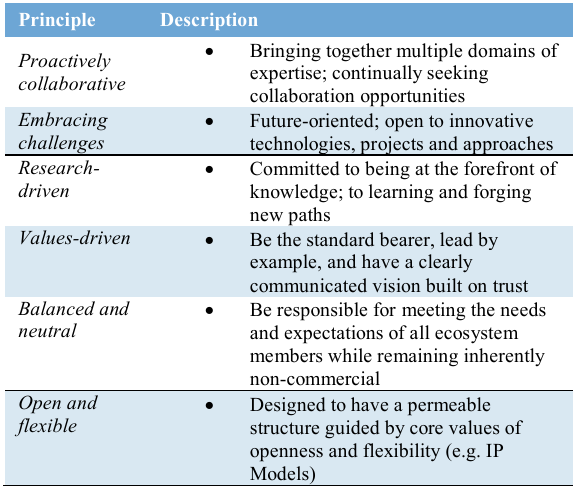
Table 2. ARM Hub’s core, demonstrable